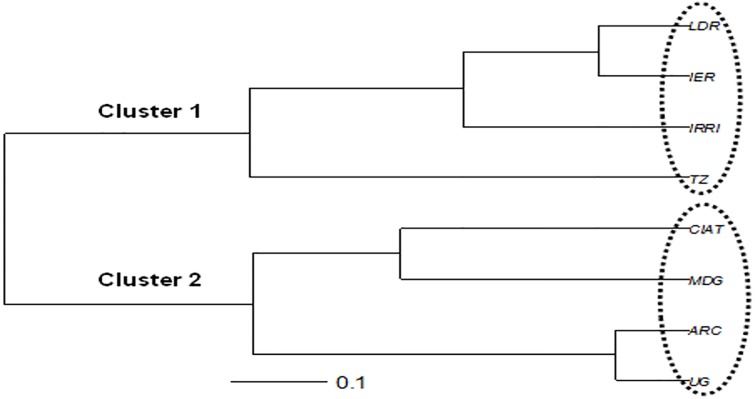
Dendrogram of a Neighbor-Joining (NJ) tree of rice populations constructed for 59 rice genotypes using DArTseq markers based on a mean fixation index (Fst) estimate value of 0.134.